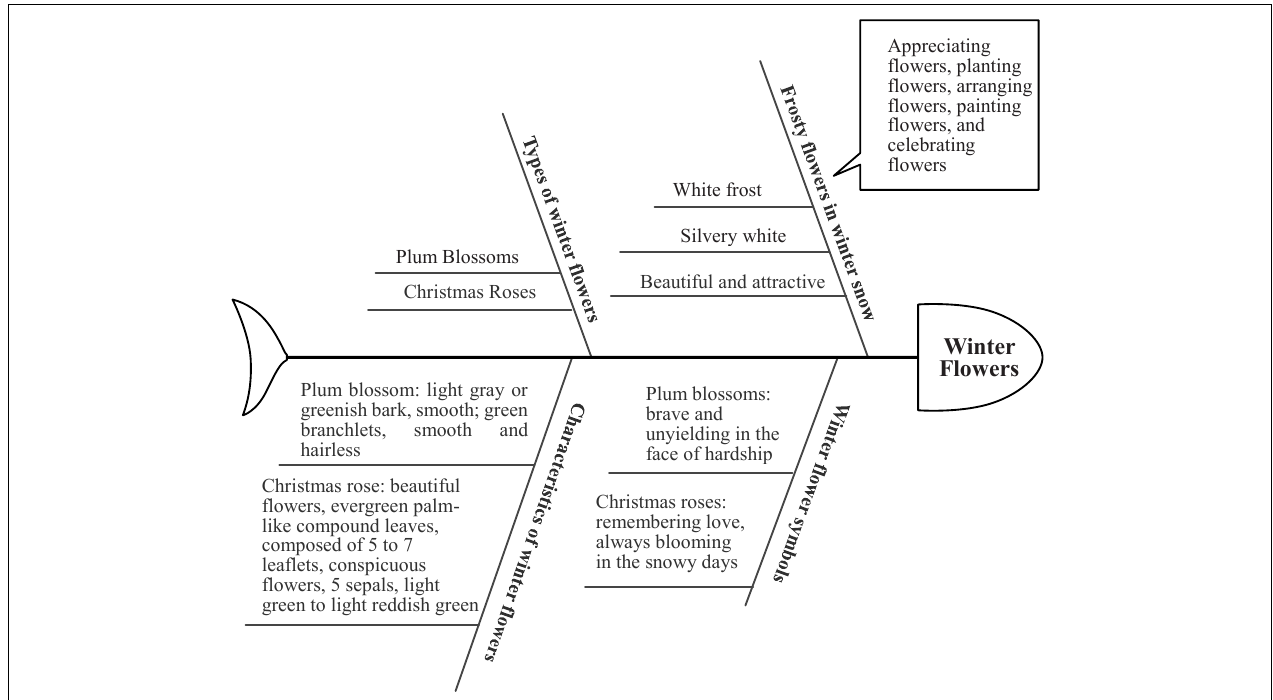
FIGURE 7 | Student A’s correction theme of the fishbone